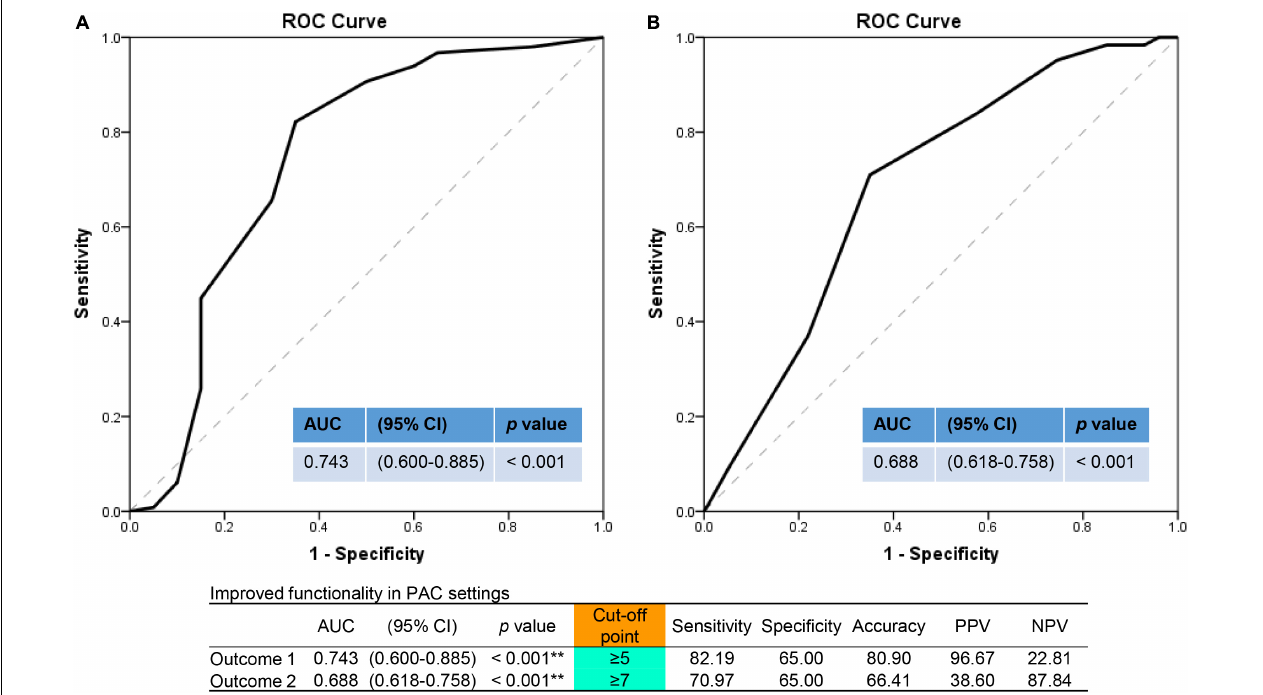
FIGURE 3 | Outcome prediction assessed by numbers of improved functionality items in the area under the ROC curve (AUC) analysis. (A) For primary outcome (1-year mortality or 14-day readmission). (B) For secondary outcome (length of hospital stay > 42 days). ROC, receiver operating characteristic curve; AUC, area under curve; PAC, post-acute care; CI, confidence interval; PPV, positive predictive value; NPV, negative predictive value. ** p <